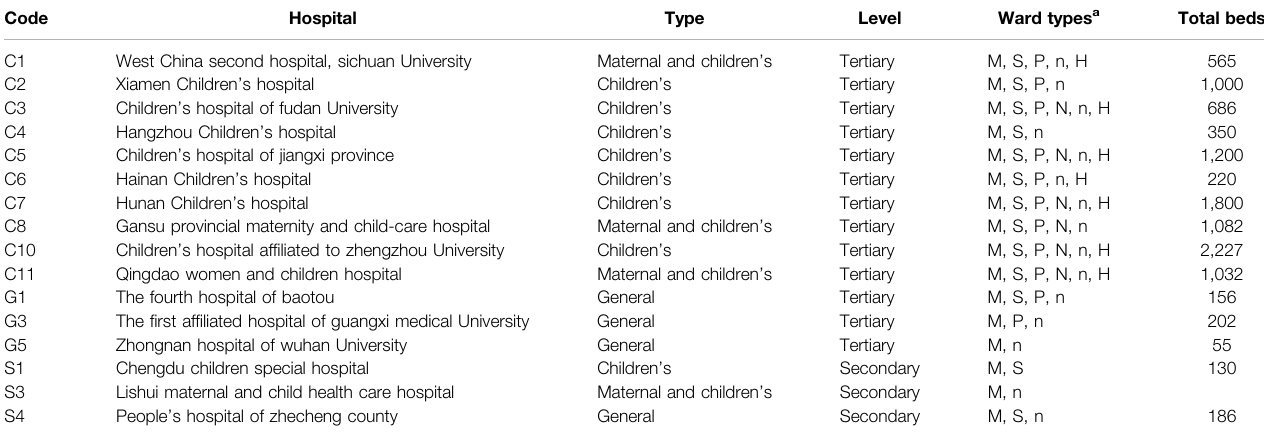
TABLE 5 | General information of participating